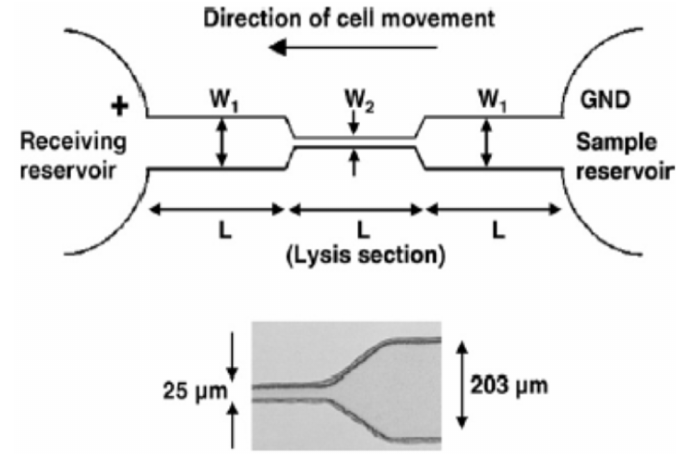
Figure 11. Microfluidic based flow through electroporation device. Cells from sample reservoir moving to the receiving reservoir and electrical lysis were confined with single cell movement through the lysis section (W Elsevier